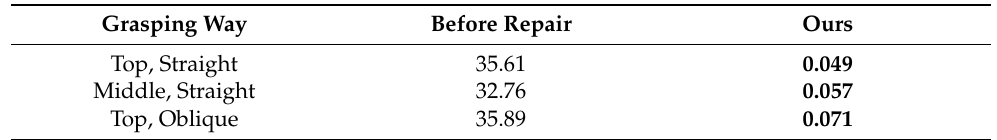
Table 3. The chamfer distance for cuboid point cloud models with different sizes using different grasping ways before and after